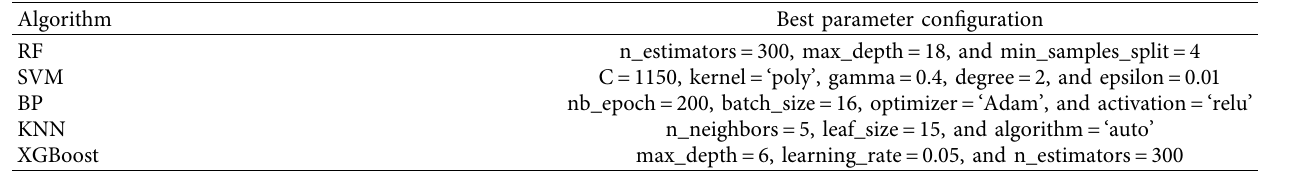
Table 2: Parameters